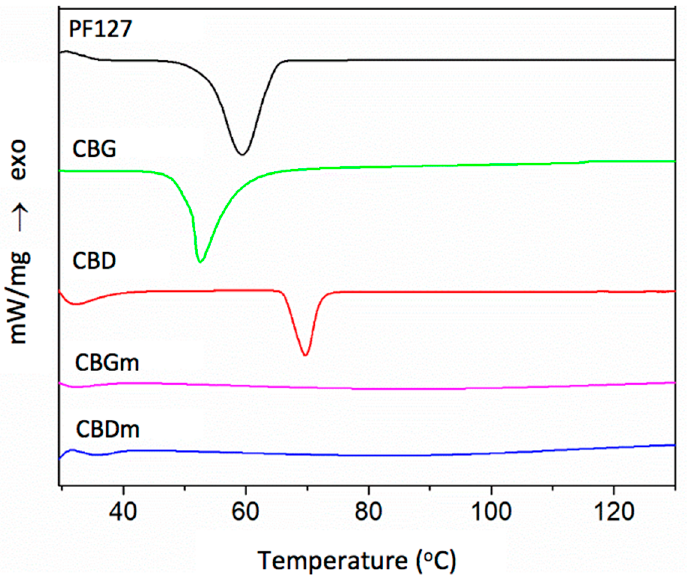
Figure 7. DSC thermograms of PF127, CBG, CBD, CBGm and